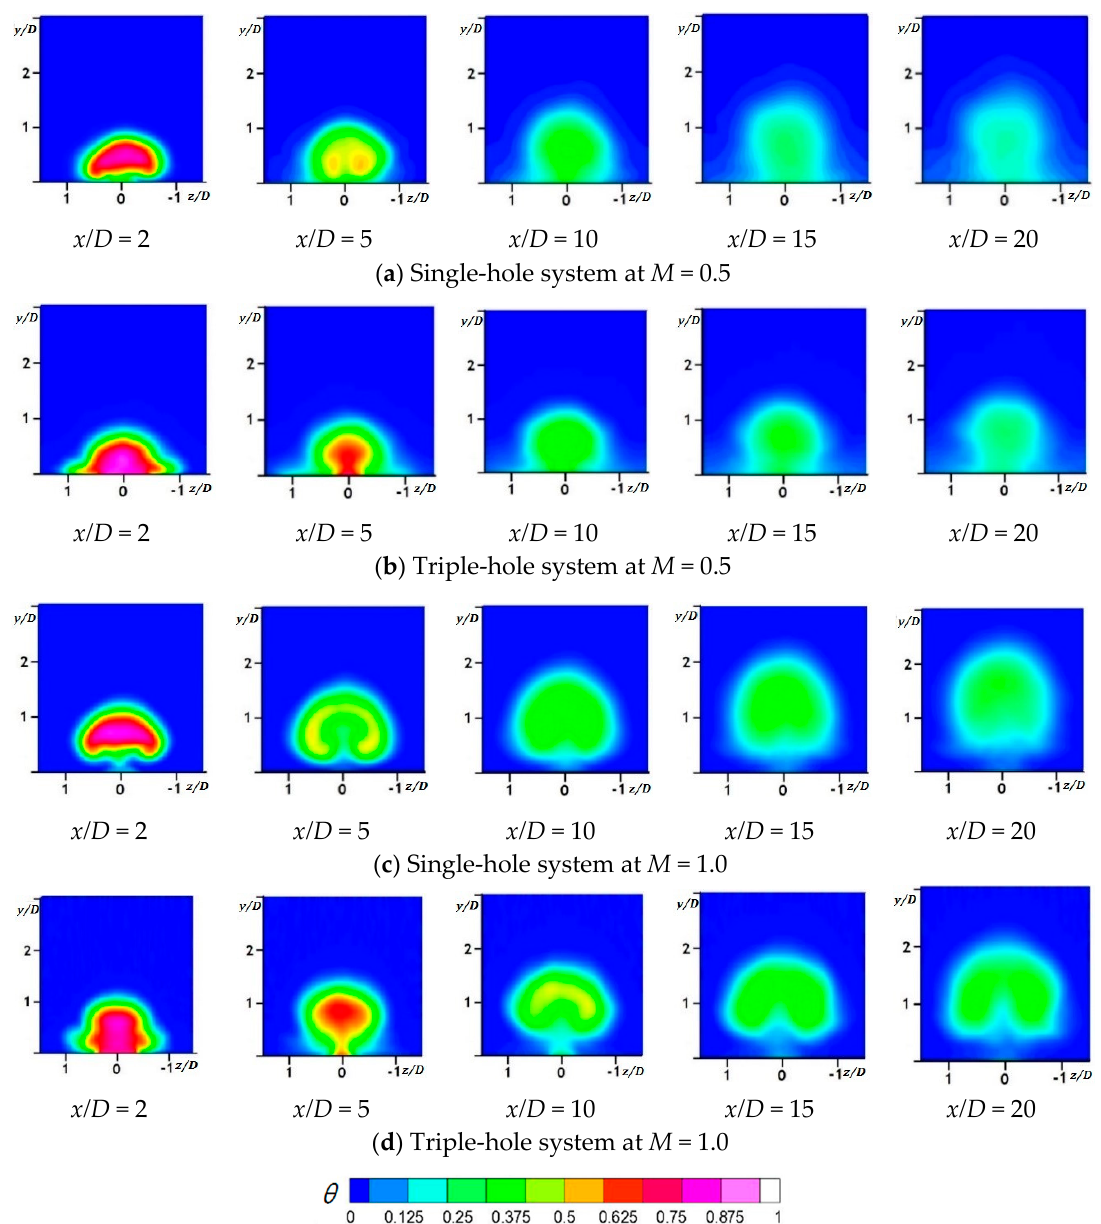
Figure 12. Cross-sectional contours of the dimensionless mean temperatures.